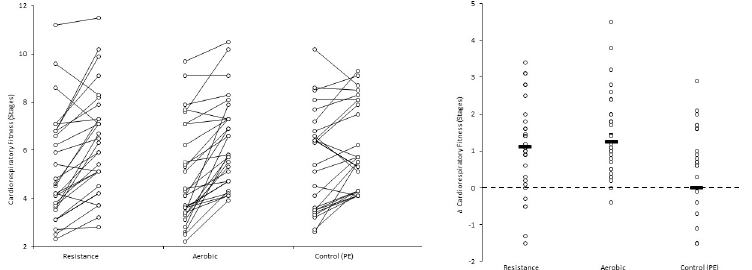
Fig 4. Left panel: Cardiorespiratory fitness (stages completed on the 20 meter shuttle-run test) pre- and post- intervention for each participant, and group means. Right panel: Individual participant and mean within-group post-intervention cardiorespiratory fitness difference post- intervention. Pairwise effect sizes for within-group difference: () resistance; d = 0.48 aerobic; d = 0.58, PE (control); d = 0.30. https://doi.org/10.1371/journal.pone.0248110.g004 P = 0.04). There was a greater increase in the sum of skinfolds (small magnitude difference) after PE (control) than resistance ( d = 0.27), while changes in resistance and aerobic did not differ. For strength, there was a significant main effect for condition ( F = 18.2, P < .001). Resis- tance was more effective (moderate magnitude difference) in increasing strength than PE (control) ( d = 0.66) and aerobic ( d = 0.55). For cardiorespiratory fitness, there was a main effect ( F = 18.2, P < .001). Resistance was more effective (small magnitude difference) than